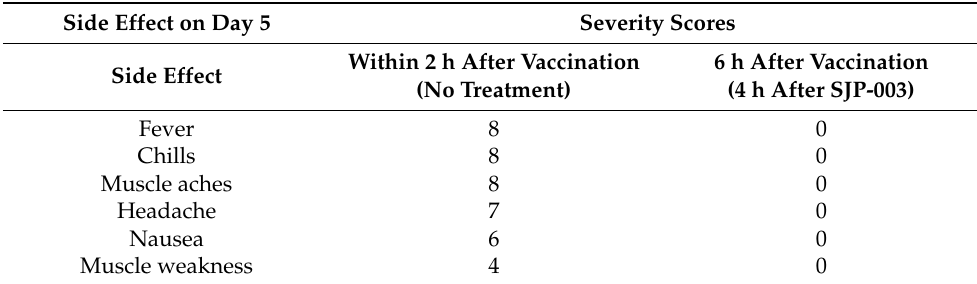
Table 1. Side effects reported after oral typhoid vaccination on day 5.